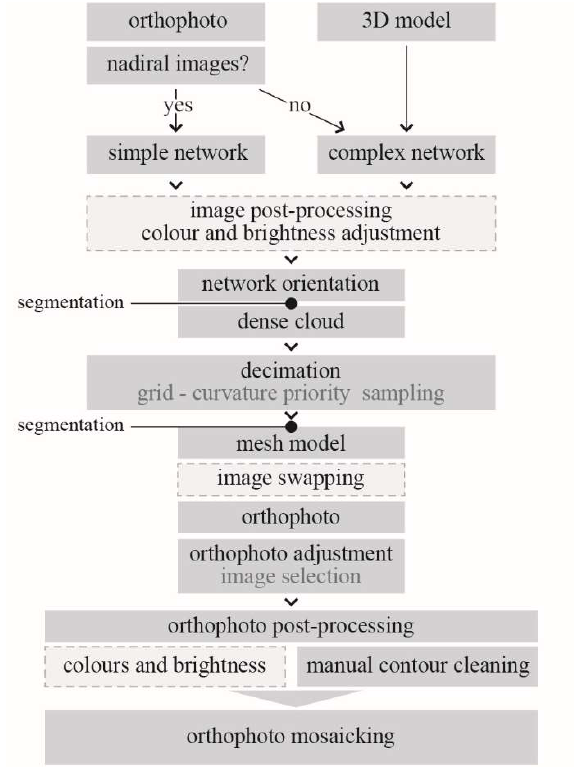
Figure 5. Pipeline for orthophotos production.